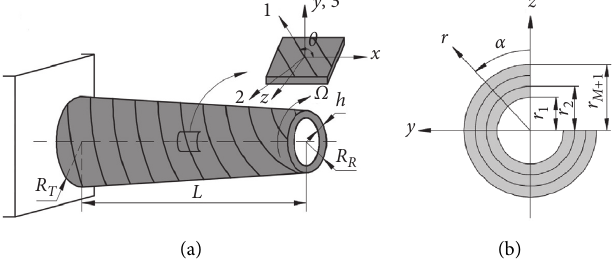
Figure 1: Schematic diagram of the rotating tapered composite cutter bar. (a) Schematic diagram of the cutter bar. (b) Cylindrical coordinate